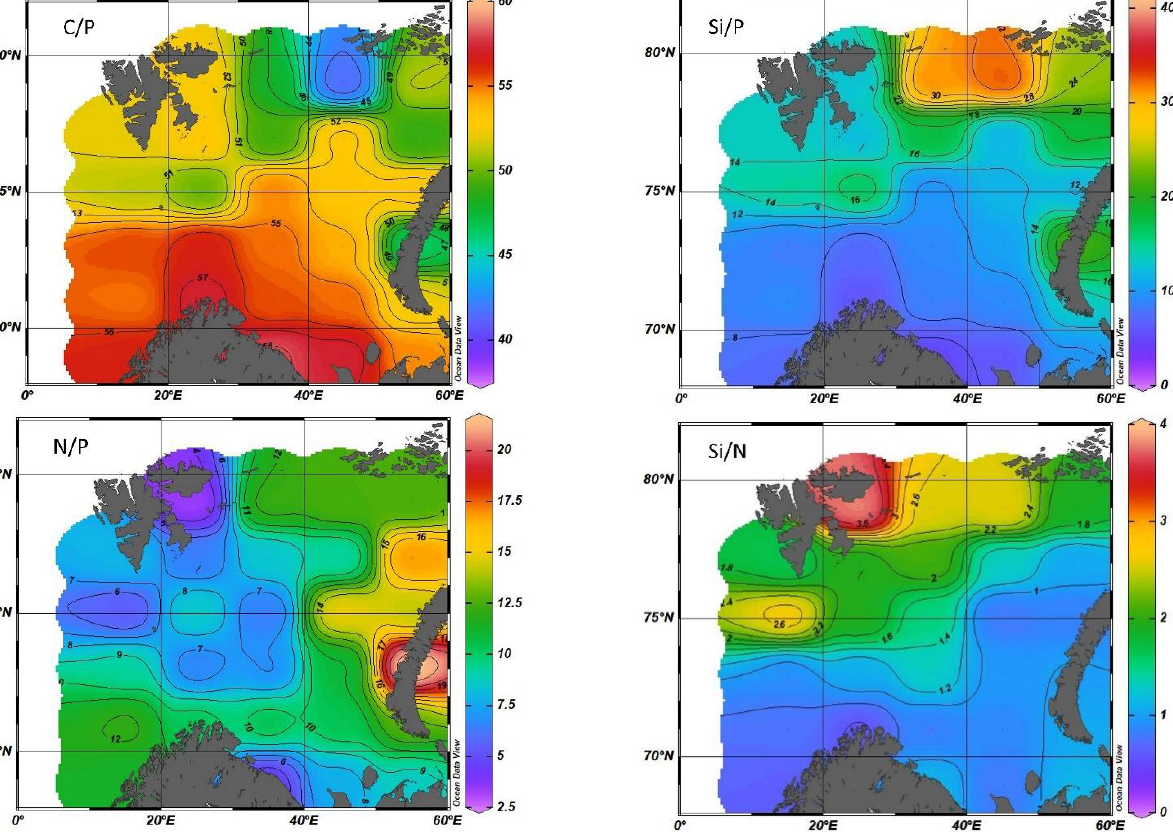
Figure 14. Distribution of stoichiometric ratios (by mass) in the Barents Sea during the period of maximum nutrient consumption (July – September).